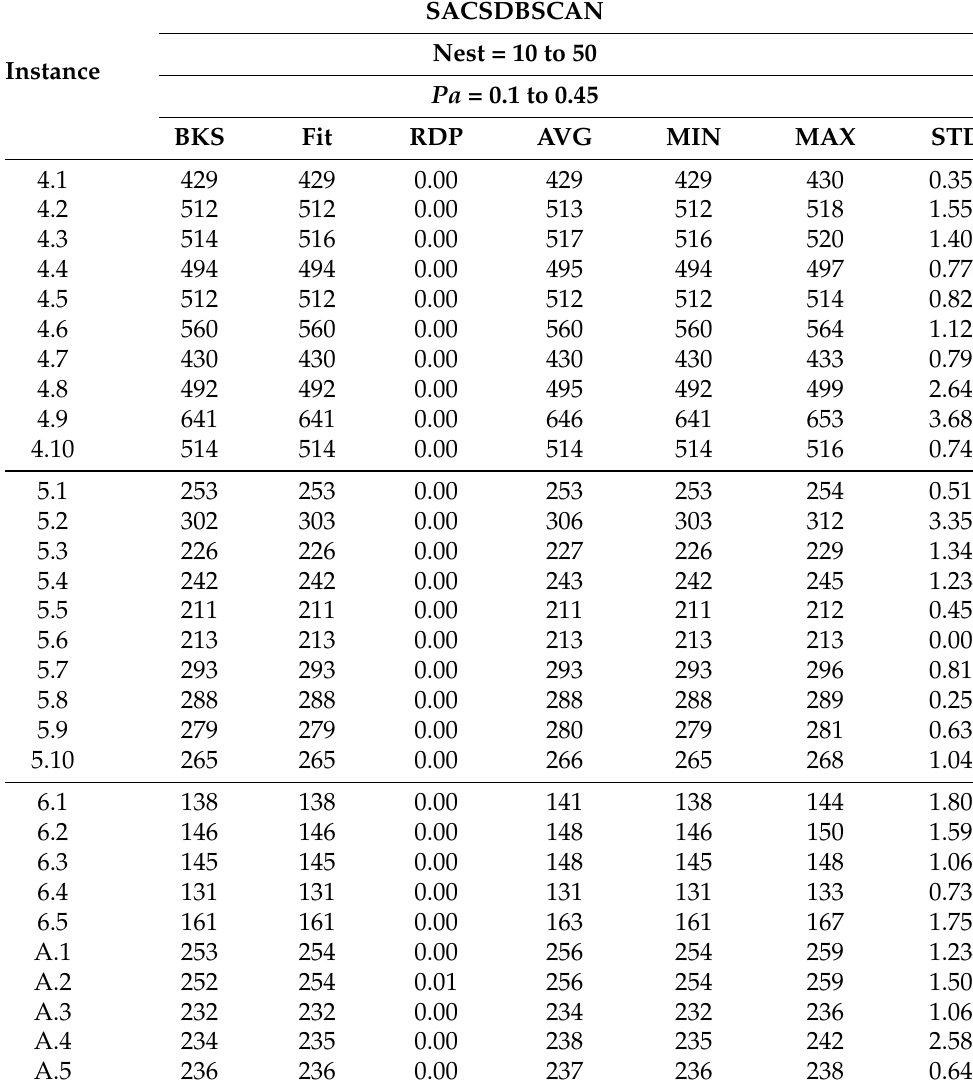
Table 3. Results of SACSDBSCAN for instance 4, 5, 6 and